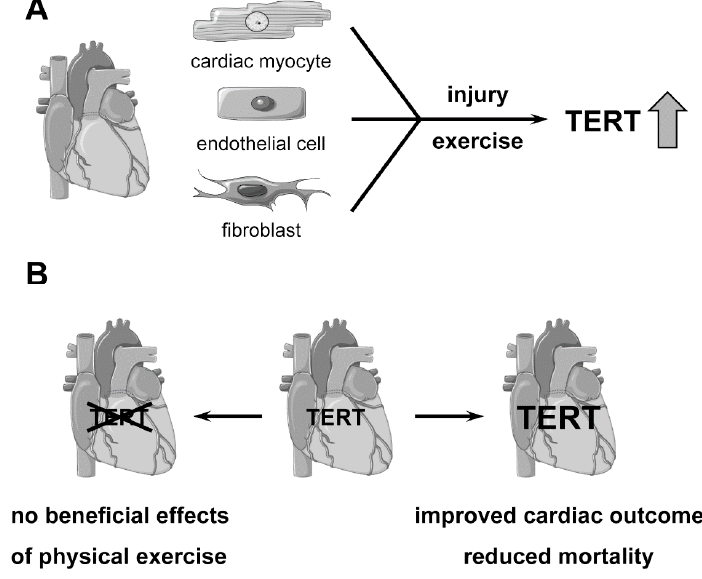
Figure 1. Regulation and functions of TERT in the heart. ( A ) TERT is present in cardiac myocytes, endothelial cells and fibroblasts of the adult heart. Heart injury as well as physical exercise increase TERT expression and Telomerase activity; ( B ) TERT deficiency completely blunts the protective effects of voluntary running in the heart. Increasing TERT levels in the heart using transgenic or viral approaches improves cardiac outcome and significantly reduces mortality.